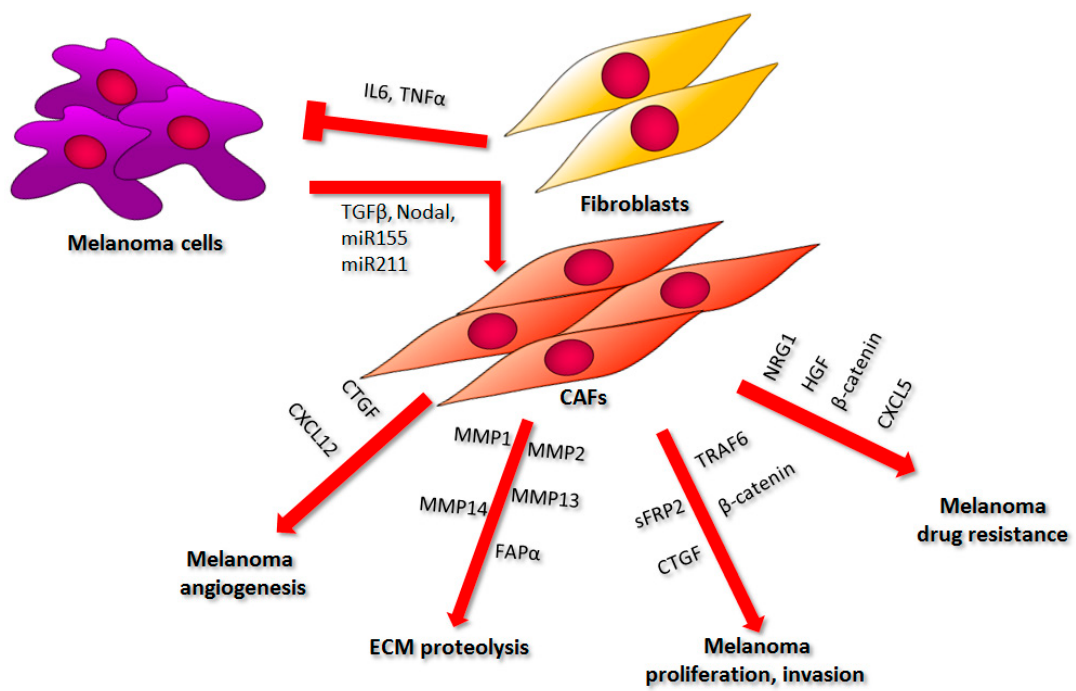
Figure 3. The influence of fibroblasts on melanoma cell proliferation, invasion, ECM remodeling, angiogenesis, and drug resistance. A description of the presented phenomena can be found in the text. Abbreviations: IL6, interleukin 6; TNF α , tumor necrosis factor α ; TGF β , transforming growth factor β ; miR155, microRNA 155; miR211, microRNA 211; CTGF, connective tissue growth factor; CXCL12, C-X-C-motif chemokine 12; MMP1, matrix metalloproteinase 1; MMP2, matrix metalloproteinase 2; MMP13, matrix metalloproteinase 13; MMP14, matrix metalloproteinase 14; FAP α , fibroblasts activating protein α ; sFRP2, freezled-related protein 2; TRAF6, TNF receptor-associated factor 6; NRG1, neuregulin1; HGF, hepatocyte growth factor; CXCL5, C-X-C-motif chemokine; ECM, extracellular matrix; CAFs, cancer-associated fibroblasts.